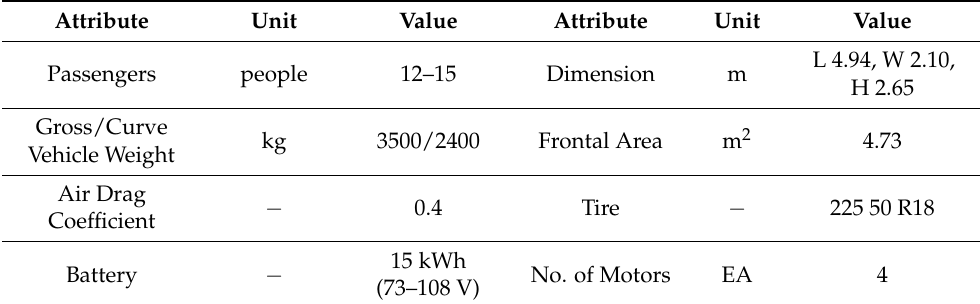
Table 1. Specifications of the target vehicle.